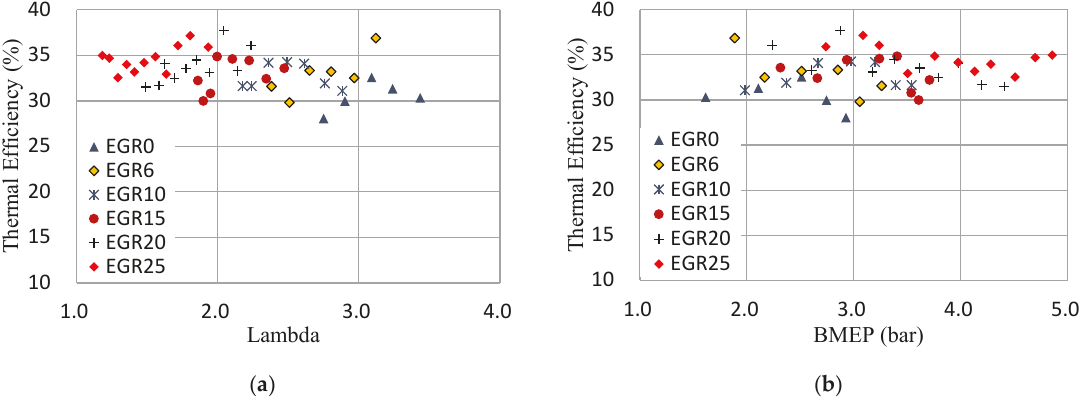
Figure 9. Brake thermal efficiency with respect to: ( a ) Lambda; ( b ) BMEP.